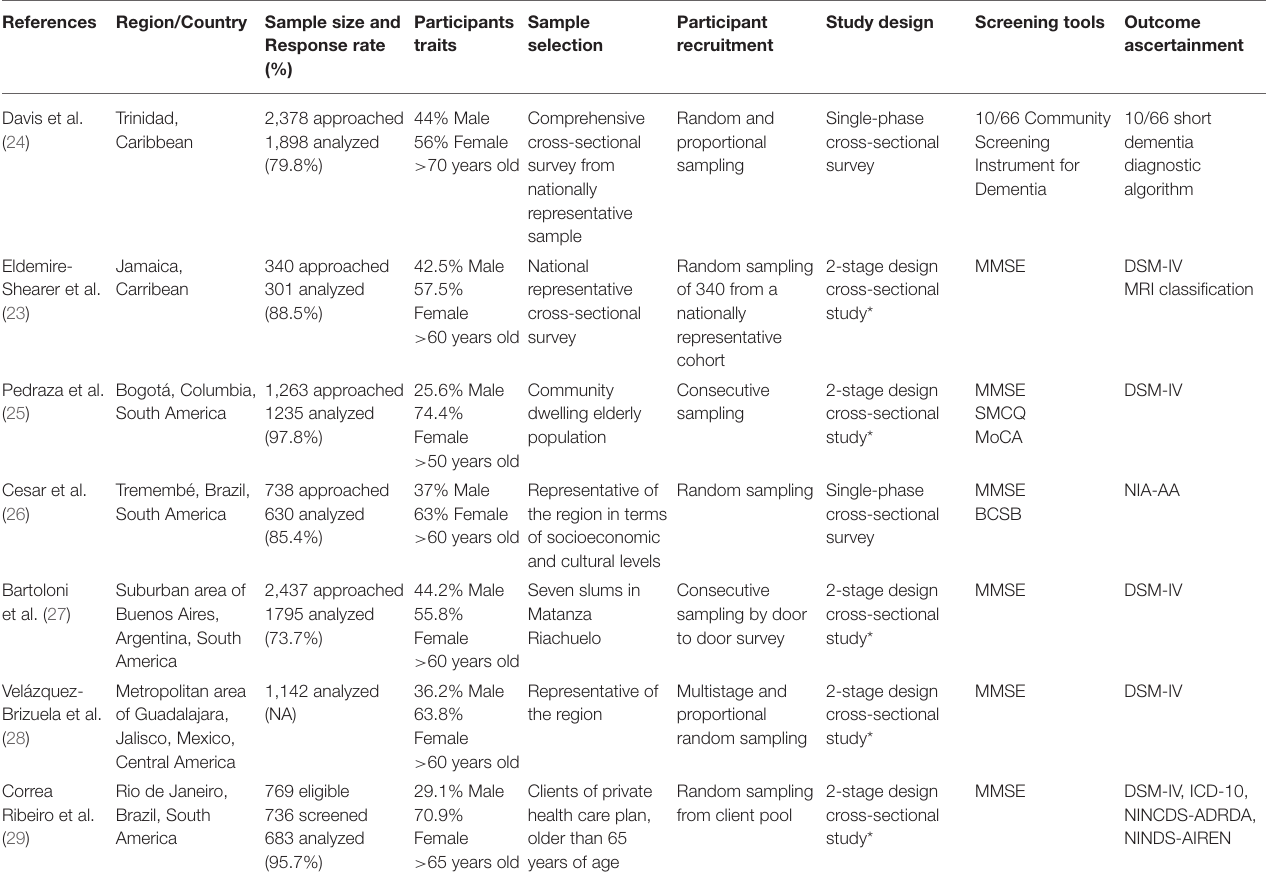
TABLE 1 | Characteristics of the retained